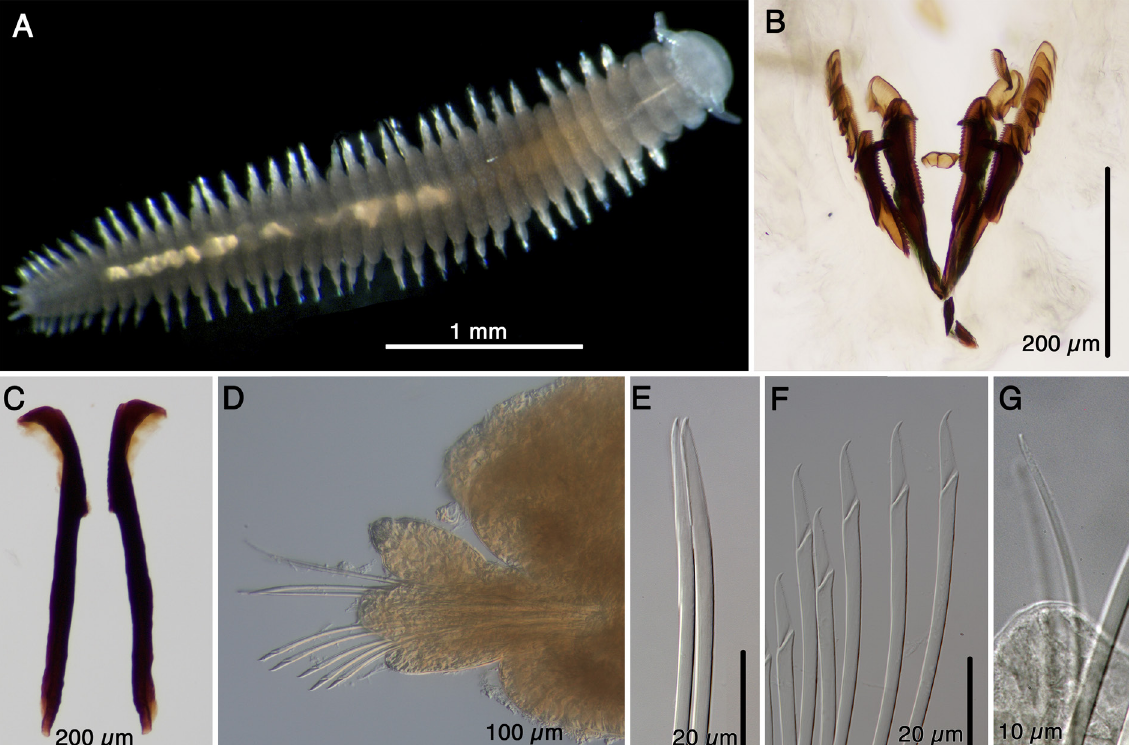
Fig. 4. Ophryotrocha charlottae sp. nov. A . Whole body of living holotype (SIO-BIC A14096). B . Maxillae of holotype (SIO-BIC A14096). C . Mandibles from holotype (SIO-BIC A14096). D . Parapodium of paratype (SIO-BIC A14098). E . Simple supra-acicular chaetae of paratype (SIO-BIC A14098). F . Compound sub-acicular chaetae of paratype (SIO-BIC A14098). G . Simple sub-acicular chaeta of paratype (SIO-BIC